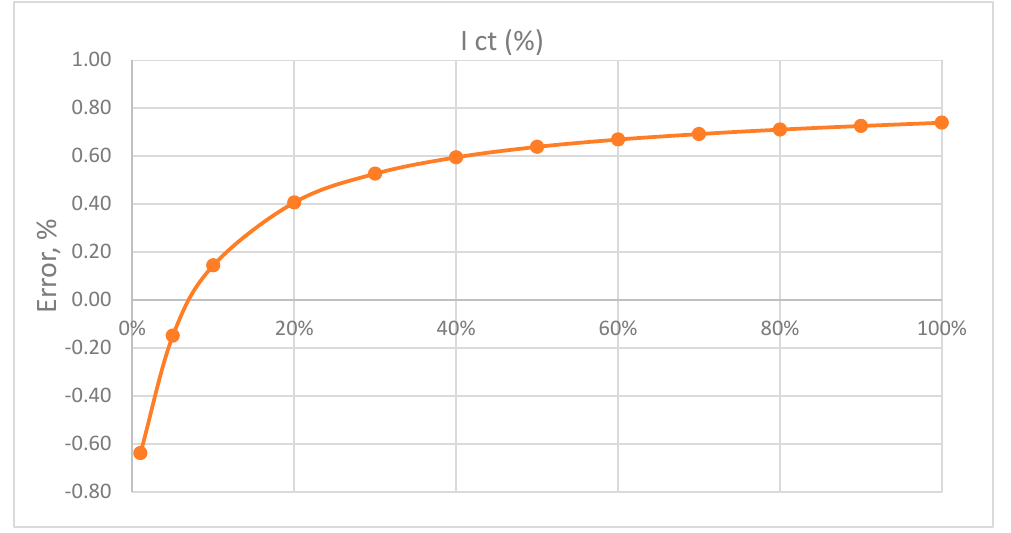
Figure 9. Figure of the error function with the correction of the number of windings n k = 99.